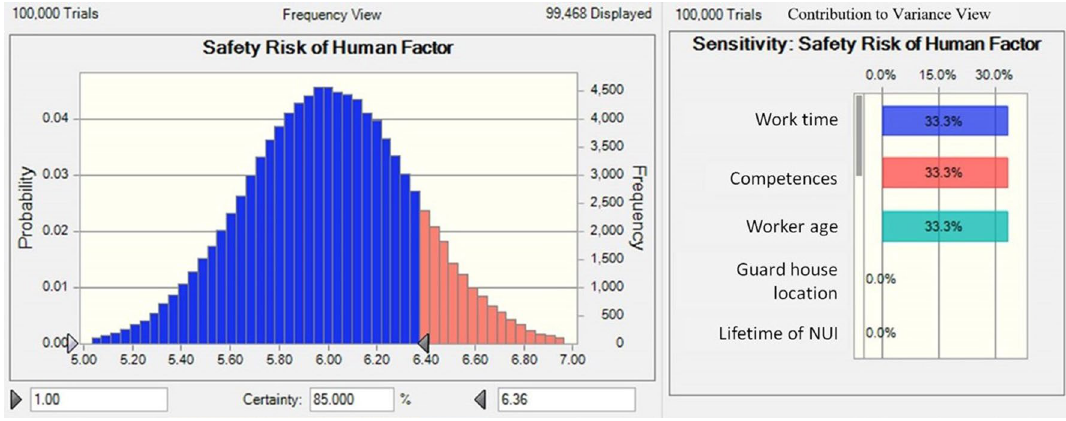
Fig. 4 Safety risk of human factors for a type A